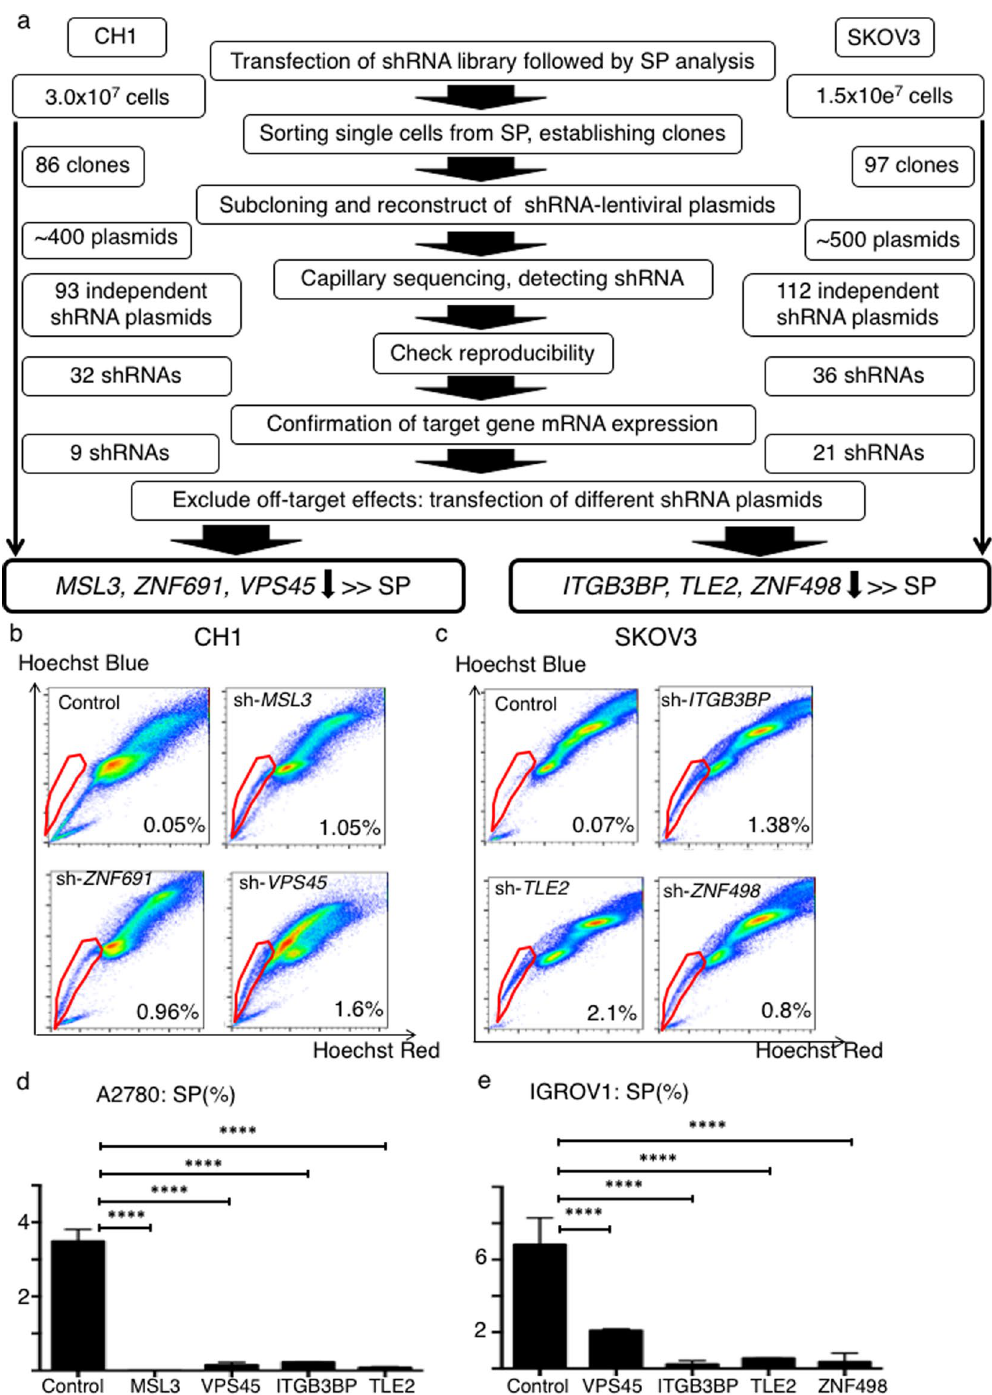
Figure 1. Schematic of functional genomics screening. ( a ) Ovarian cancer cell lines, CH1 and SKOV3 were used. Following transfection of the shRNA library, we performed SP analysis and SP cells were singly plated into each well of 96-well plates. We established 86 clones in the CH1 screen and 97 clones in the SKOV3 screen. shRNAs were amplified by PCR and we reconstructed 93 different shRNA plasmids from the CH1 screen and 115 different shRNA plasmids from the SKOV3 screen. Out of 97 shRNAs in CH1 cells, 32 again markedly increased the SP fraction. Out of 115 shRNAs in SKOV3 cells, 36 again markedly increased the SP fraction. We measured mRNA expression of these 32 and 36 genes using RT-PCR, and found that 9 shRNAs in CH1 suppressed their target gene’s mRNA expression and 21 shRNAs in SKOV3 suppressed their target gene’s mRNA expression. We transfected shRNAs containing completely different anti-sequence than those initially used for each gene and performed SP analysis and RT-PCR to exclude off target effects. We identified MSL3 , ZNF691 and VPS45 , whose downregulation markedly increased the SP fraction of CH1 cells and ITGB3BP , TLE2 and ZNF498 whose downregulation markedly increased the SP fraction of SKOV3 cells. ( b )